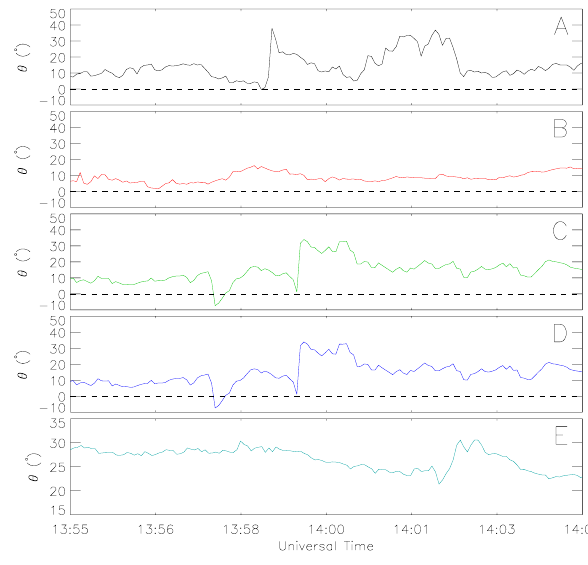
Fig. 16. The GSM elevation angle of magnetic field for the four Cluster spacecraft (panels A–D ) and the latitude angle of dB for TC-2 (panel E